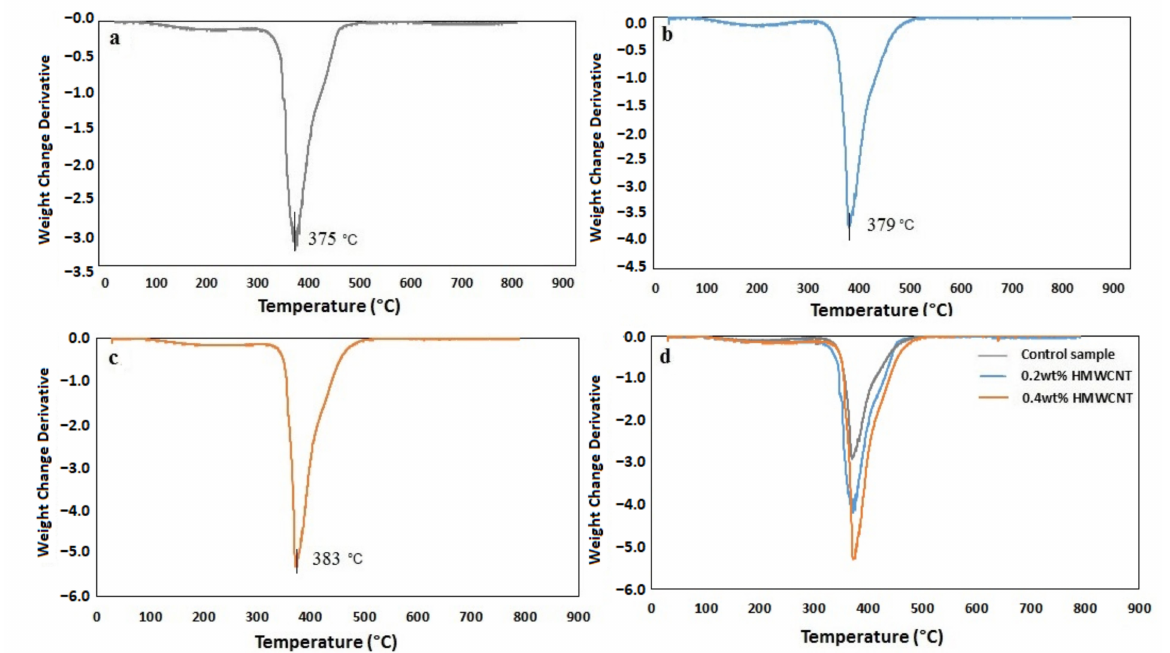
Figure 11. Derivative curves calculated from the TGA profiles of the ( a ) control sample, the ( b ) 0.2 wt.% HMWCNT, the